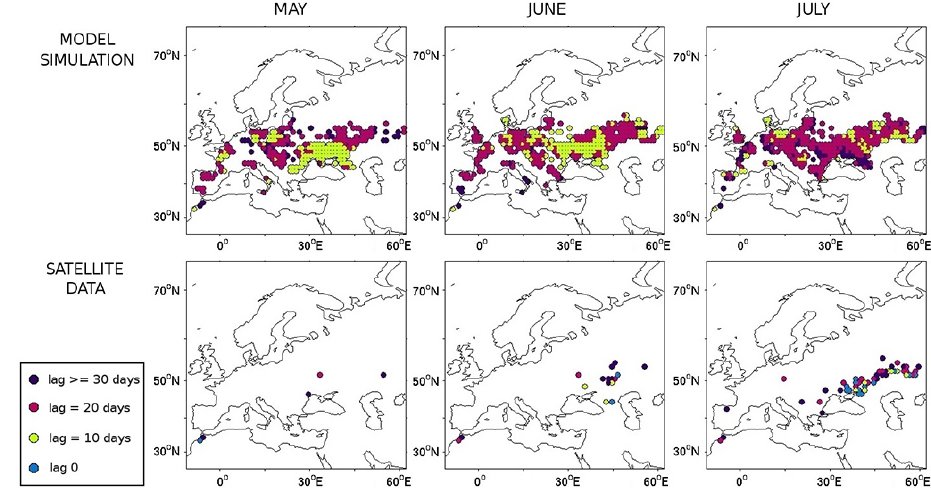
Figure 13. Predictability of LAI 10-daily differences from SSM over croplands from May to July, based on detrended (top) ISBA-A- gs simulations and (bottom) satellite-derived products (GEOV1 LAI and ESA-CCI SSM). The colour dots correspond to four time lags providing the highest squared coefficient correlation ( r 2 ) for the predicted LAI anomaly over the 1991–2008 period. The results are given for the second 10-day period of each month at grid cells presenting significant LAI anomaly estimates ( p value <